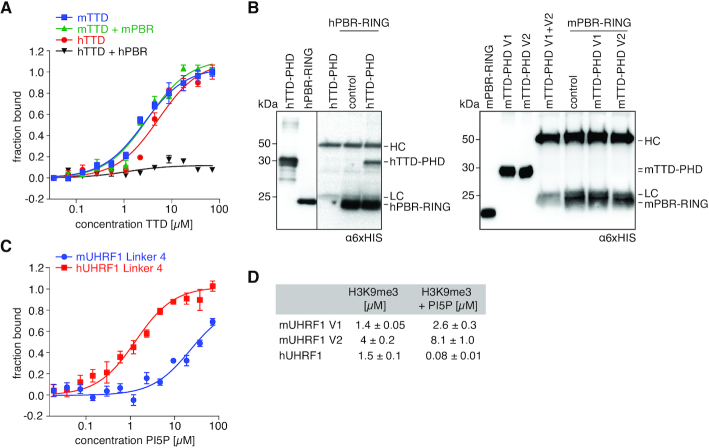
mTTD is not regulated by mLinker 4/ mPBR. (A) Titration series of recombinant mTTD and hTTD with a FAM-H3(1–15)K9me3 peptide with and without twofold molar excess of oligopeptides corresponding to mPBR or hPBR were analysed by fluorescence polarization. Data are plotted as average of three independent experiments; error bars correspond to s.d. (B) Recombinant mPBR-RING and hPBR-RING proteins were immobilized on magnetic beads and incubated with mTTD-PHD V1, V2 or hTTD-PHD. Protein input and recovered material were analysed by western blot. Running positions of molecular weight markers (left) and different identified proteins (right) are indicated. (C) Titration series of PI5P with fluorescently labelled, recombinant mLinker 4 or hLinker 4 was analysed by microscale thermophoresis. Data are plotted as average of three independent experiments; error bars correspond to s.d. (D) Dissociation constants (KD) for H3K9me3 peptide binding in the absence and presence of 100-fold molar excess of 16:0 PI5P over recombinant murine and human UHRF1 proteins as determined by microscale thermophoresis. Results represent averages of minimally three independent experiments; error bars correspond to s.d.